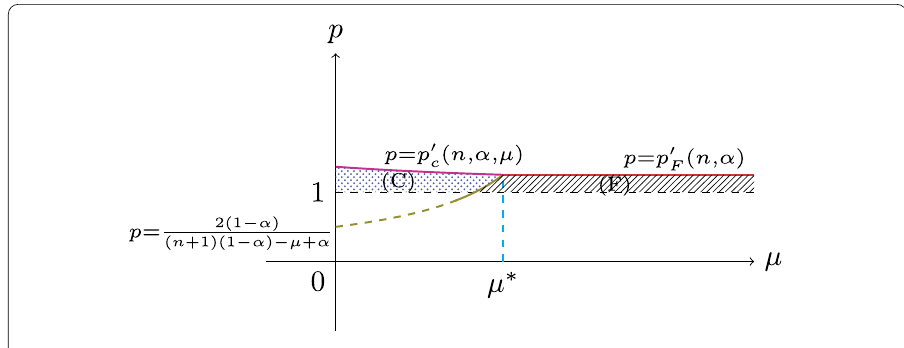
Figure 3 Range of blow-up conditions in case n = 3 and α = 0